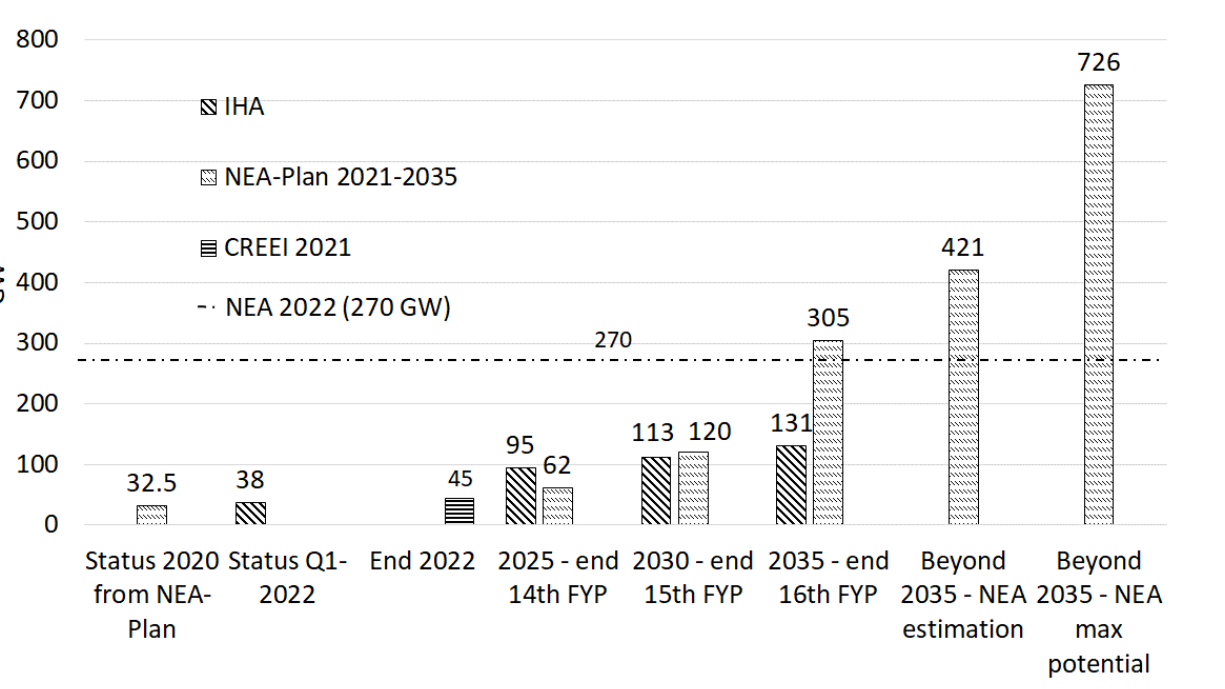
Figure 10. NEA-Plan and IHA Database cumulative PHS installations (turbine mode): comparing planned time schedules. Data from CREEI Report and NEA June 2022 Announcement are also in- cluded for reference.